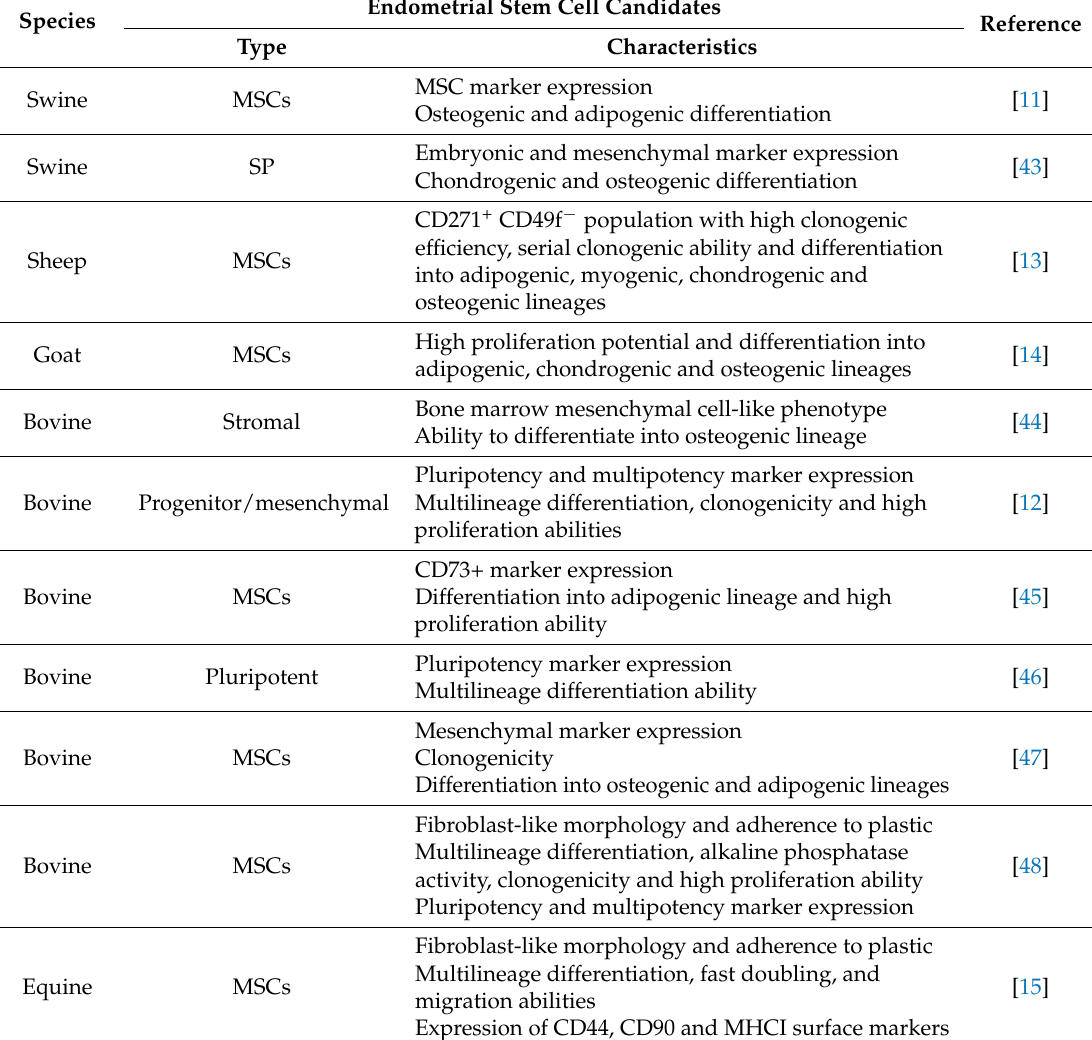
Table 1. Summary of studies that have identified possible candidates for endometrial stem cells in farm